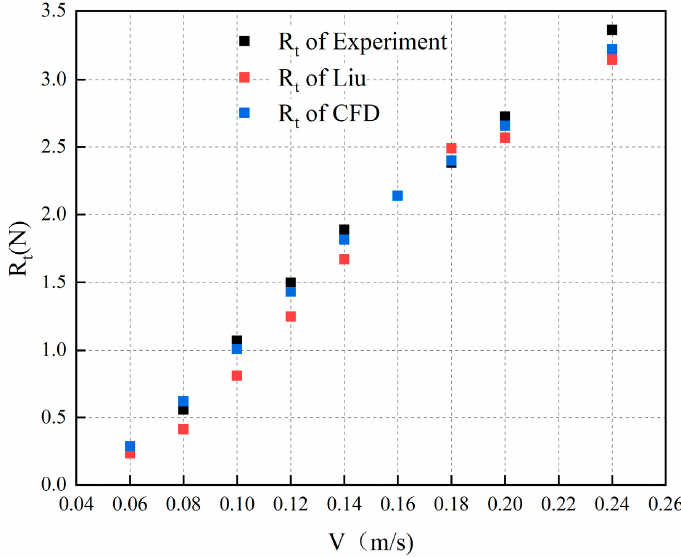
Figure 2. Comparison of numerical simulation results. Table 1. The experimental results for resistance of the box-shaped structure. Figure 3. The length of the bare hull is 99.4 m. The upper fluid is fresh water. The density ρ 1 = 997.561 kg/m 3 . The lower fluid is salt water. ρ 2 = 1024 kg/m 3 . D 1 = 0.16 L. d 2 = 0.1 L. The sailing speed is Fr = 0.5.